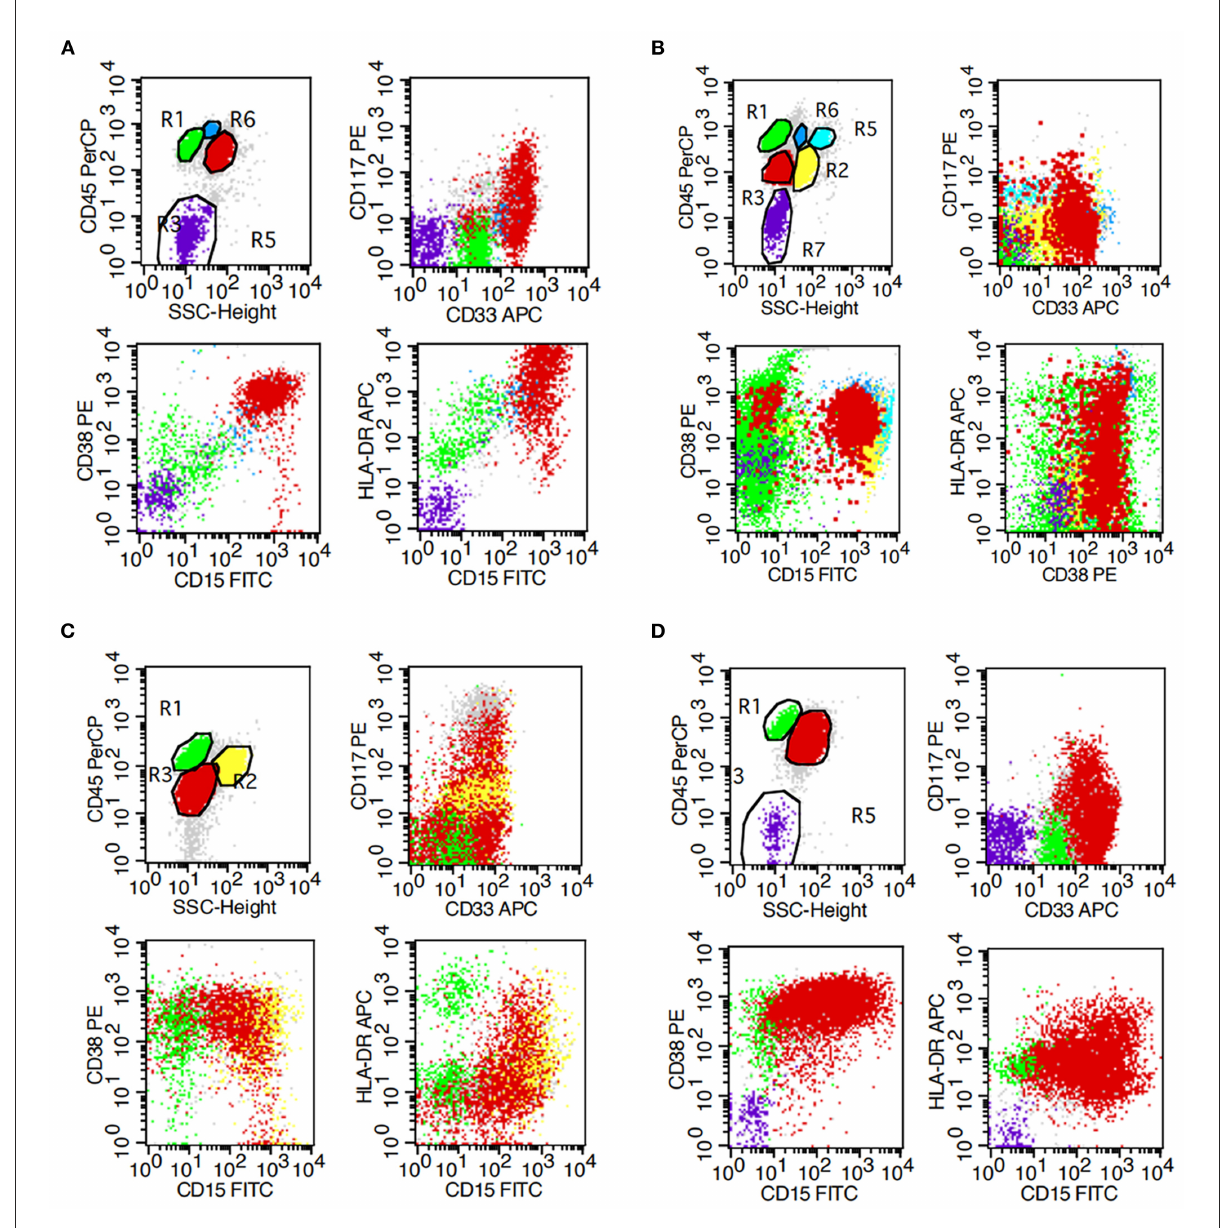
FIGURE2 Flow cytometry results of bone marrow. (A–D) represent cases 1, 2, 3, and 4,